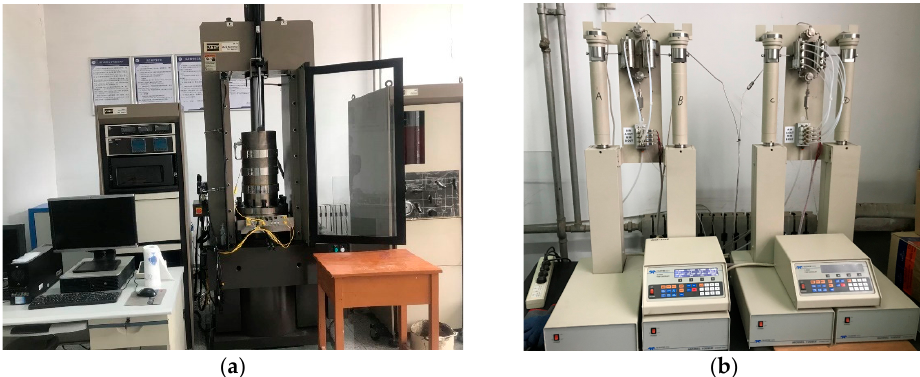
Figure 2. Test equipment: ( a ) MTS815 rock mechanics testing machine and ( b ) Teledyne ISCO D-Series Pumps.